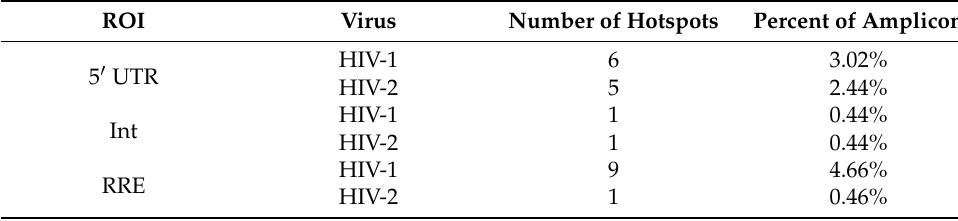
Table 1. Number of plasmid mutation hotspots identified in each